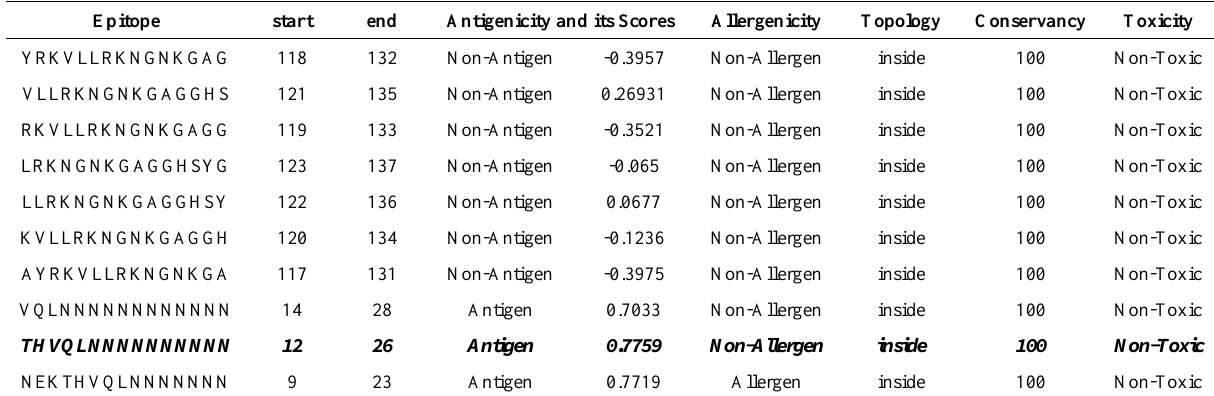
Table 5. List of MHC Class-II epitopes for selected leader protein ORF1ab MT326102 along with their antigenicity scores, allergenicity, topology, conservancy scores, and their respective toxicities. The epitope in bold italics is selected for further 3D Structure generation.